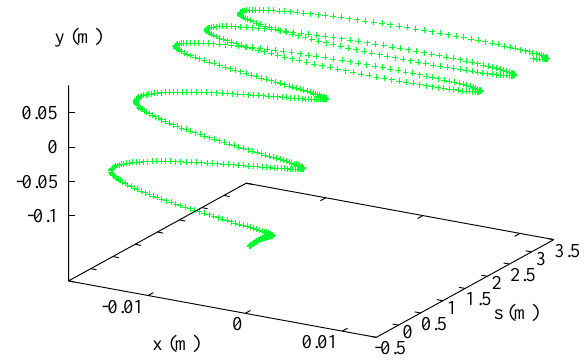
FIG. 5. (Color) Vertical drift with cusp motion in three dimen- sions, as a function of the length along the beam line (cid:115) , in beam coordinates. The beam enters at the lower right. It begins to perform a vertical drift and an oscillation around a displaced equilibrium orbit. At the end of the bend, its perpendicular mo- mentum produces oscillations around the original undisplaced horizontal